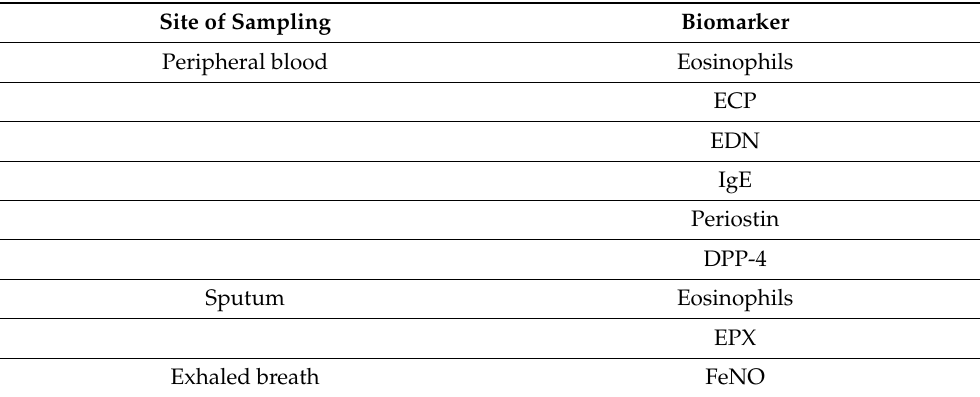
Table 1. Principal biomarkers in T2 asthma and their common site of sampling in clinical